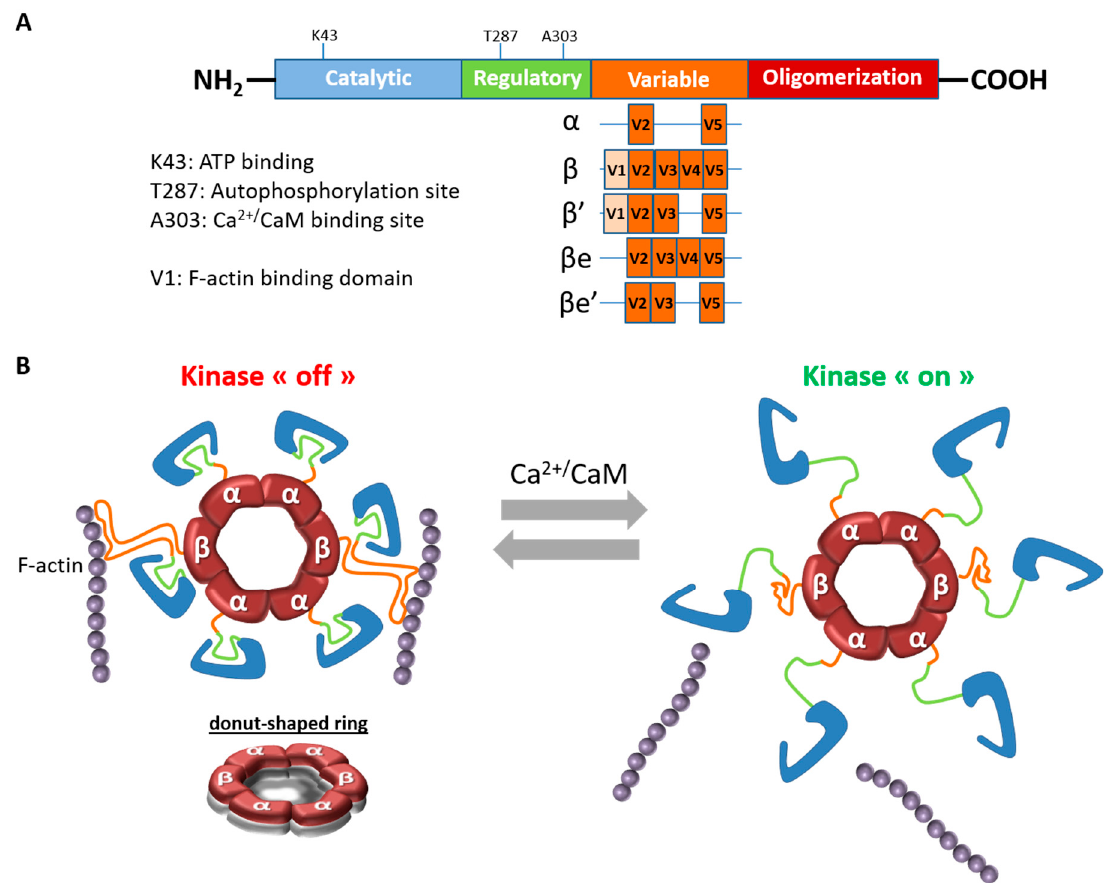
Figure 1. Structural organization of CaMKII β . ( A ). Schematic representation of CaMKII β structure and its variants. CaMKII α and CaMKII β differ mostly in the variable region. The variable region of CaMKII α only contains V2 and V5 domains. The variable region V1, which is absent in CaMKII β e and CaMKII β ’e, is necessary for the binding to the actin cytoskeleton. ( B ) Calcium/calmodulin-dependent protein kinase II (CaMKII) is organized into large oligomers typically of 12 or 14 subunits. Central to the organization of CaMKII is the hub domain, also known as the association or oligomerization domain, which forms a donut-shaped ring that is the core of the holoenzyme (see side view). The kinase domains are tethered to the central hub by the regulatory segments. In basal condition, the CaMKII holoenzymes, via CaMKII β , bind to actin filaments, particularly in dendritic spines. Upon Ca 2 + influx, Ca 2 + / CaM binds to a CaM-binding element in the regulatory segment of CaMKII, releasing it from the kinase domain and thereby activating the enzyme. At the same time, CaMKII holoenzymes detach from F-actin and it can be recruited to the synapse to induce functional changes.